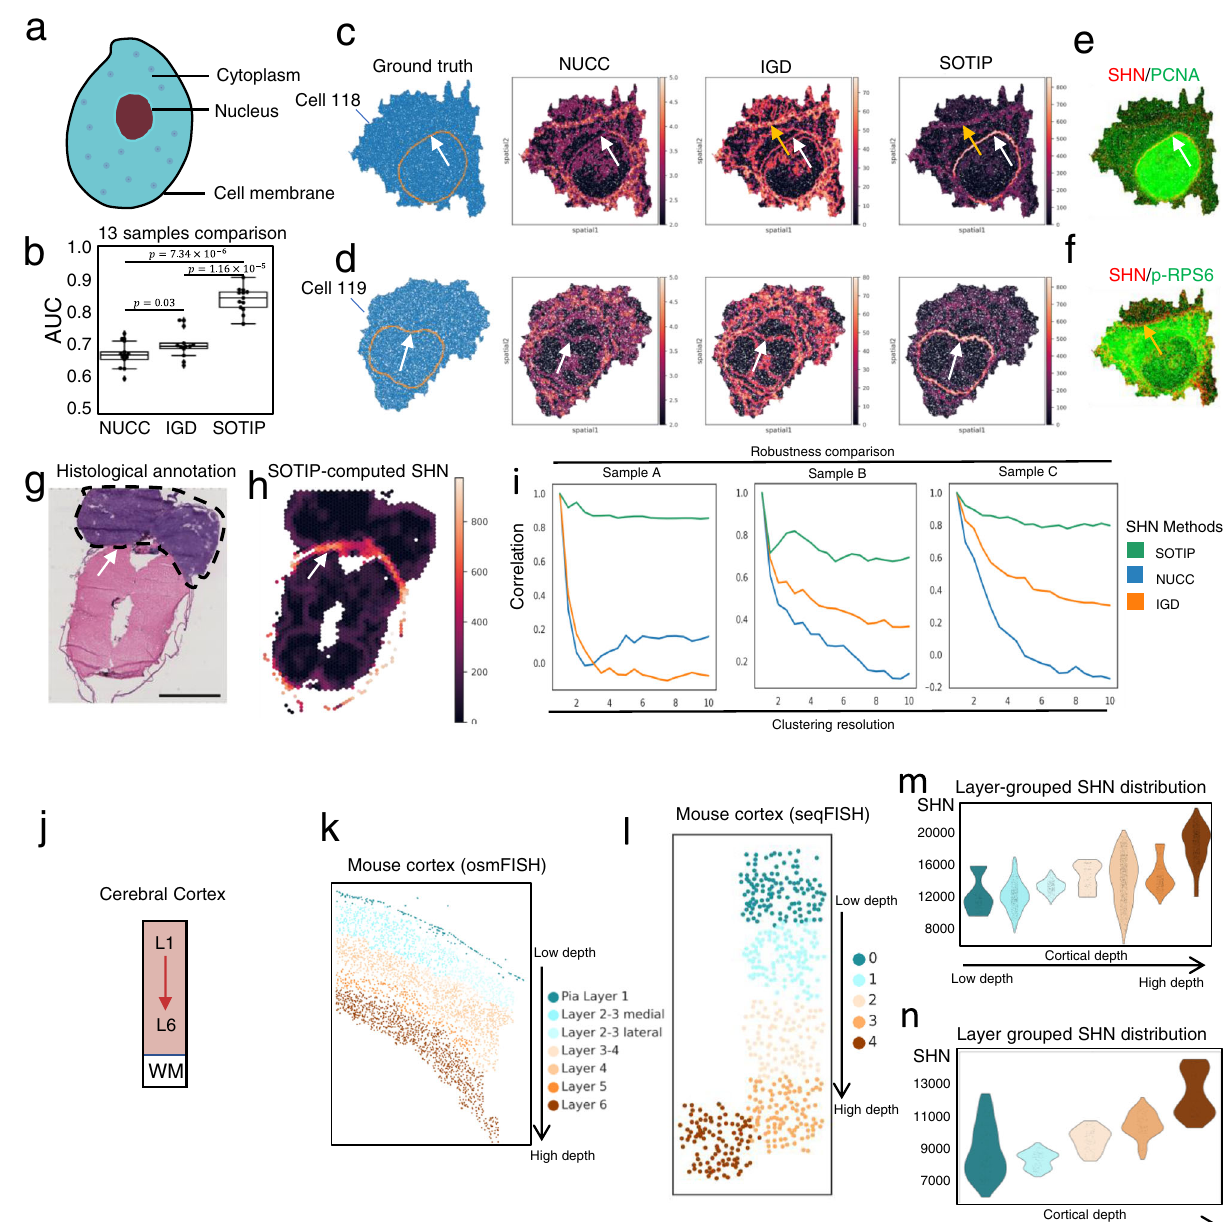
Fig. 3 | SOTIP accurately quanti fi es spatial heterogeneity. a Schematic diagram of a eukaryotic cell. b Summary of the SHN quanti fi cation performance on all 13 samples. The AUC is used to estimate the performance. Two-sided Wilcoxon rank-sumtest.Thedetailedde fi nitionofboxplotelementsisdescribedinMethods. The boxplots show n =13 biologically independent cells. c Visualization of the ground truth (1st column) and SHN values computed by NUCC (2nd column), IGD (3rd column),and SOTIP (4th column) in cell118.White arrows point out the same position of nuclear envelope. Orange arrow points out a computed potential intracellular membrane structure. d Similar with c but for cell 119. e Overlay of SOTIPcomputedSHNvalueswithPCNAproteinexpressionincell118.Whitearrow pointsoutthesamepositionwithFig.3c. f OverlayofclippedSOTIPcomputedSHN valueswithp-RPS6expressionincell118.Orangearrowpointstothesameposition asinFig.3c4thcolumn. g Histologicalimageofthezebra fi shdata.Tumorregionis annotated with black dashed line. Scale bar: 2mm. h 10x Visium spots are paired with Fig. 3g, colored according to SOTIP computed SHN values. i The stability